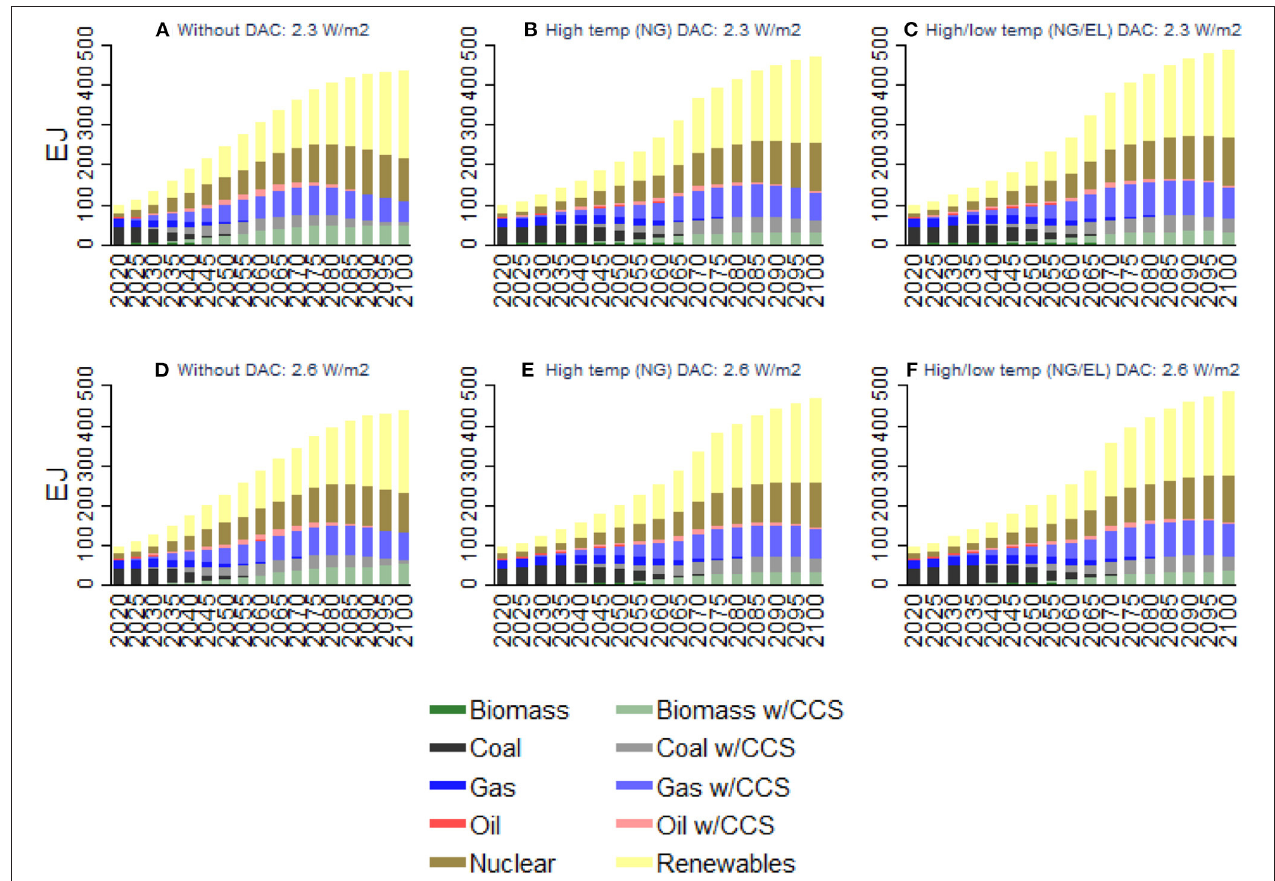
FIGURE 4 | Supply of electricity and generation mix in the global power sector under the least cost climate mitigation scenarios that aim to achieve climate mitigation goal by limiting the total radiative forcing to 2.3 and 2.6 W/m 2 by year 2100, respectively. The three panels in the top row shows the electricity generation mix under the 2.3 W/m 2 by year 2100 and the three panels in the bottom row shows the electricity generation mix under the 2.6 W/m 2 by year 2100. The scenario “Without DAC” includes only BECCS and AR, the scenario “High temp (NG) DAC” includes a high temperature natural gas-based DAC in addition to BECCS and AR, and the scenario “High/low temp (NG/EL) DAC” includes three types of DAC (high temperature natural gas-based DAC, high temperature electricity-based DAC and low temperature electricity-based DAC) in addition to BECCS and